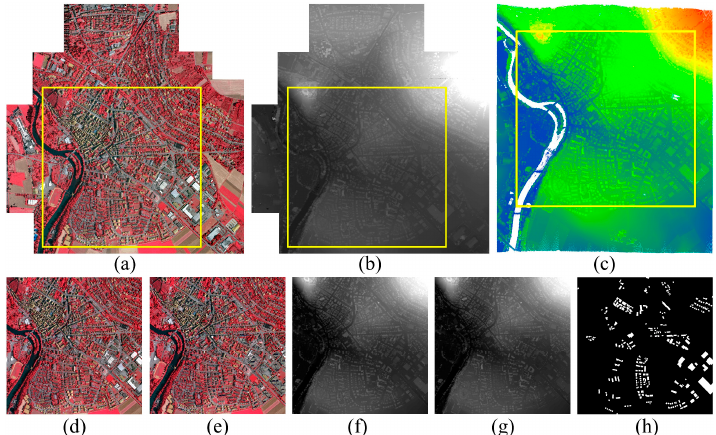
Figure 7. Vaihingen Dataset of ( a ) Image, ( b ) DSM and ( c ) Point cloud; ( d ) Study area-original; ( e ) Study area-assumed; ( f ) nDSM-original; ( g ) nDSM-assumed; ( h ) Ground truth, where white indicates changed region and black indicates unchanged region.